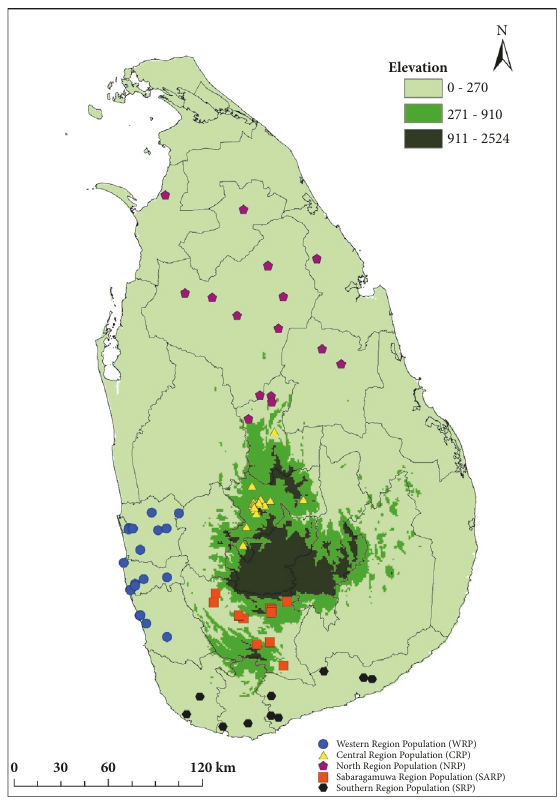
Figure 2: The schematic representation of the collection localities of Indian cobra venom